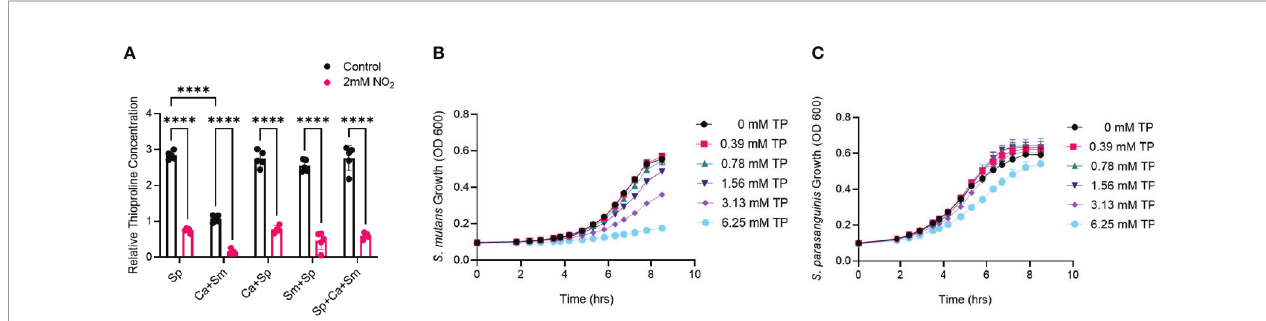
FIGURE 3 | S. parasanguinis is resistant while S. mutans is sensitive to the nitrite trapping antioxidant thioproline. (A) Relative thioproline abundance from metabolomics analysis. (B) Growth of S. mutans on thioproline (C) Growth of S. parasanguinis on thioproline. All growth curve cultures were grown in tryptic soy broth containing 0.5% yeast extract (+/- 2 mM thioproline) at 37°C with 5% CO 2 . ****p < 0.0001. (Student ’ s t-test). Data are representative of three biological